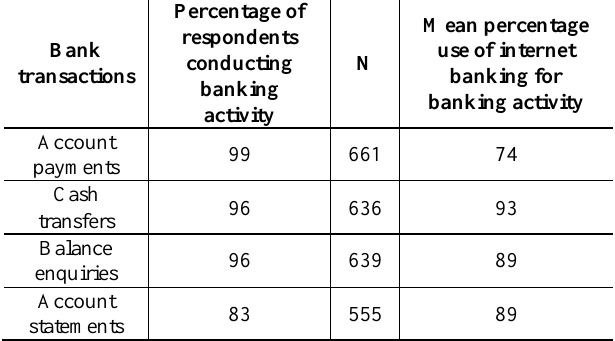
Table 1: Self-reported use of internet banking by the users of only internet